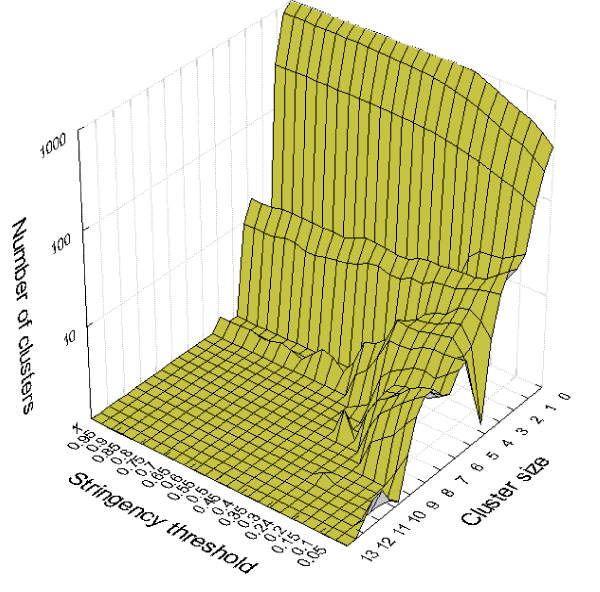
Effect of stringency threshold variation on the clustering results. The only free parameter in both loose and stringent clustering applications is the stringency threshold. This picture shows distribution of cluster size (axis X – categories by cluster size from 1 to 13, axis Z – number of clusters of certain size, decimal logarithmic scale) after clustering of 885 human EST with a threshold value (parameter) ranging from 0.05 to 0.9 (axis Y) with a step of 0.05.